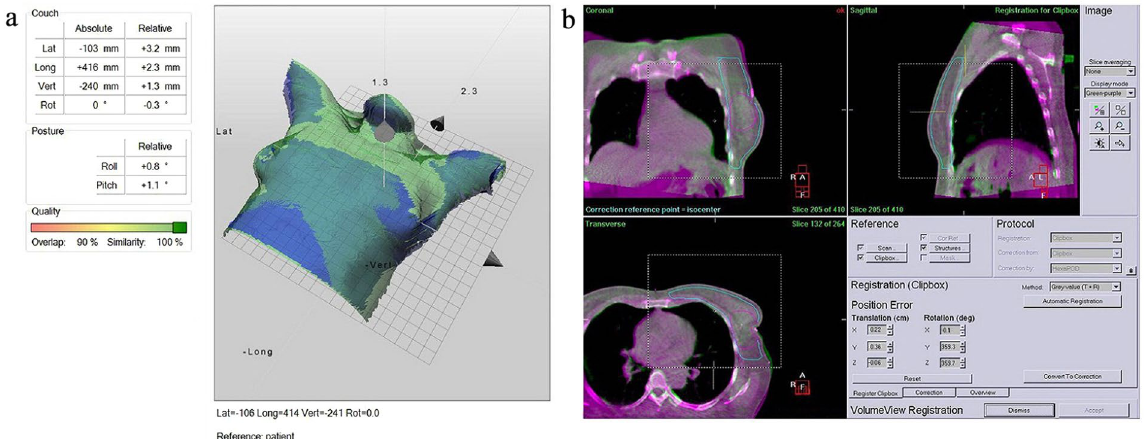
Figure 2. The images and data of setup corrections by Sentinel ( a ) and CBCT ( a , b ): The green area represents the body surface profile reconstructed by CT scan, the blue area represents the body surface profile reconstructed by Sentinel scan, and the dark blue represents areas that match with errors. The data on the left is the result of matching error.